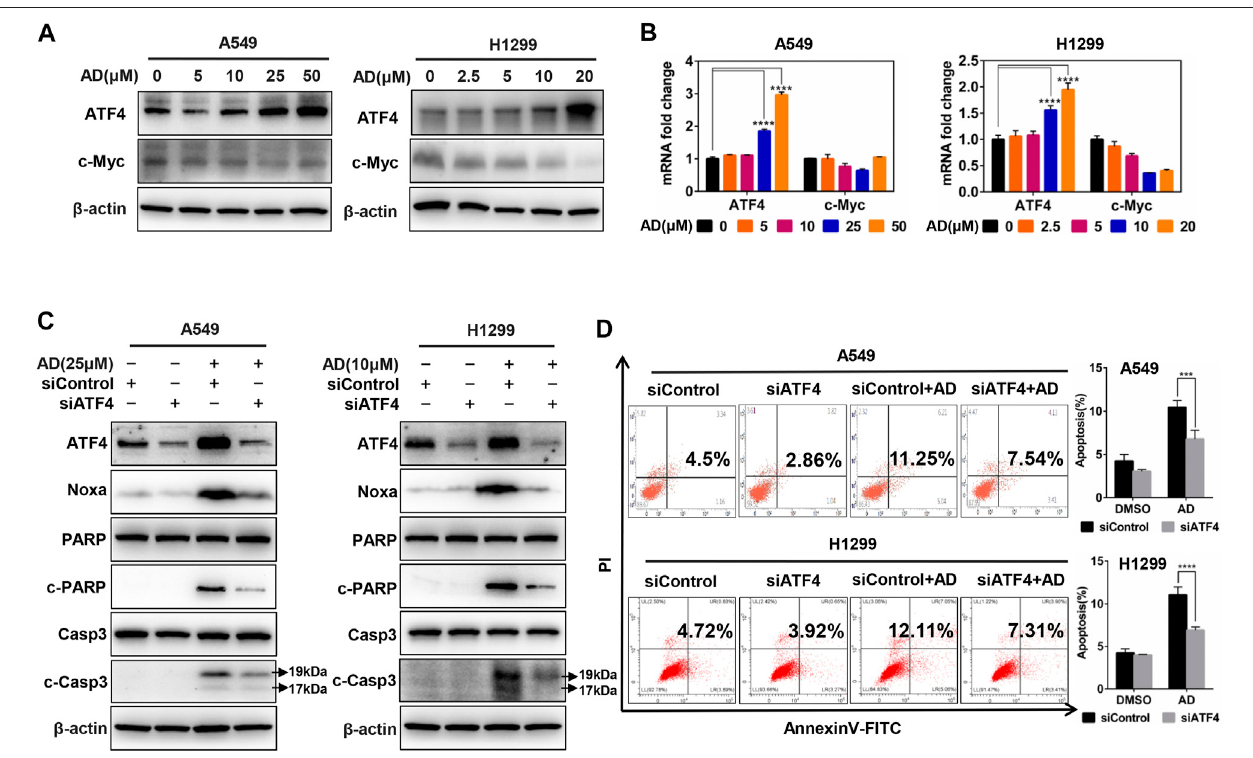
FIGURE 5 | Andrographolide induced apoptosis in human lung adenocarcinoma cells via ATF4/Noxa axis. (A – B) Cells were treated with 1 ‰ DMSO or indicated concentrationsofADfor24 h; cellprotein wasextracted anddetectedbywesternblottingwithantibodiesagainst ATF4and c-Myc.ThemRNA levelofATF4and c-Myc was quanti fi ed with RT-PCR (normalized to β -actin). (C – D) Cells were transfected with siControl or siATF4, then, treated with 1 ‰ DMSO or AD (A549 25 μ M, H1299 10 μ M) for 24 h, cell protein was extracted and detected by western blotting with antibodies against ATF4, Noxa, PARP, c-PARP, Casp3, c-Casp3, and β -actin. Apoptosis was determined and quanti fi ed by AnnexinV-FITC/PI staining analysis (* p ≤ 0.05; *** p ≤ 0.001; **** p ≤